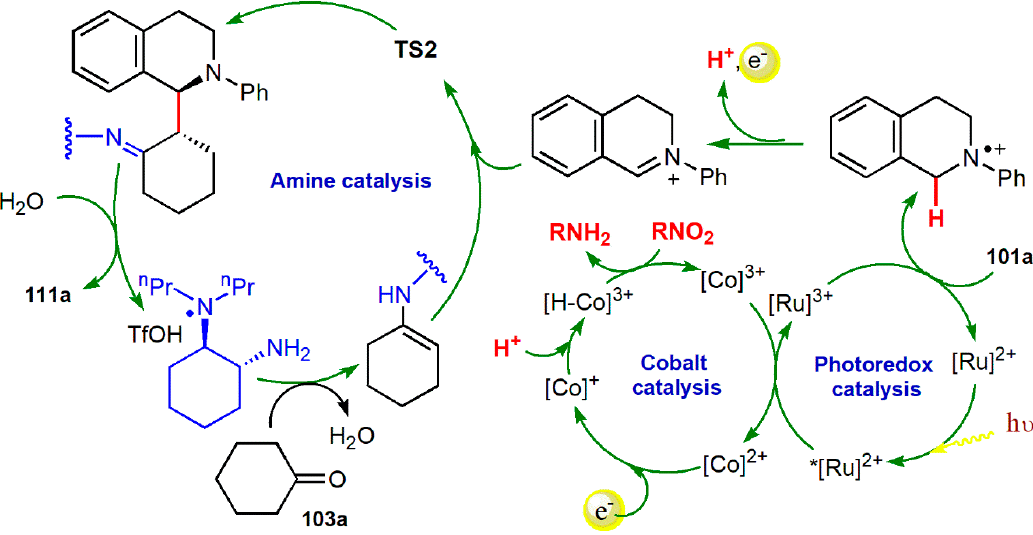
Figure 34. The mechanism proposed for the asymmetric CDC of tertiary amines and ketones catalyzed by a synergistic combination of Co and Ru-based catalysts and 108 .